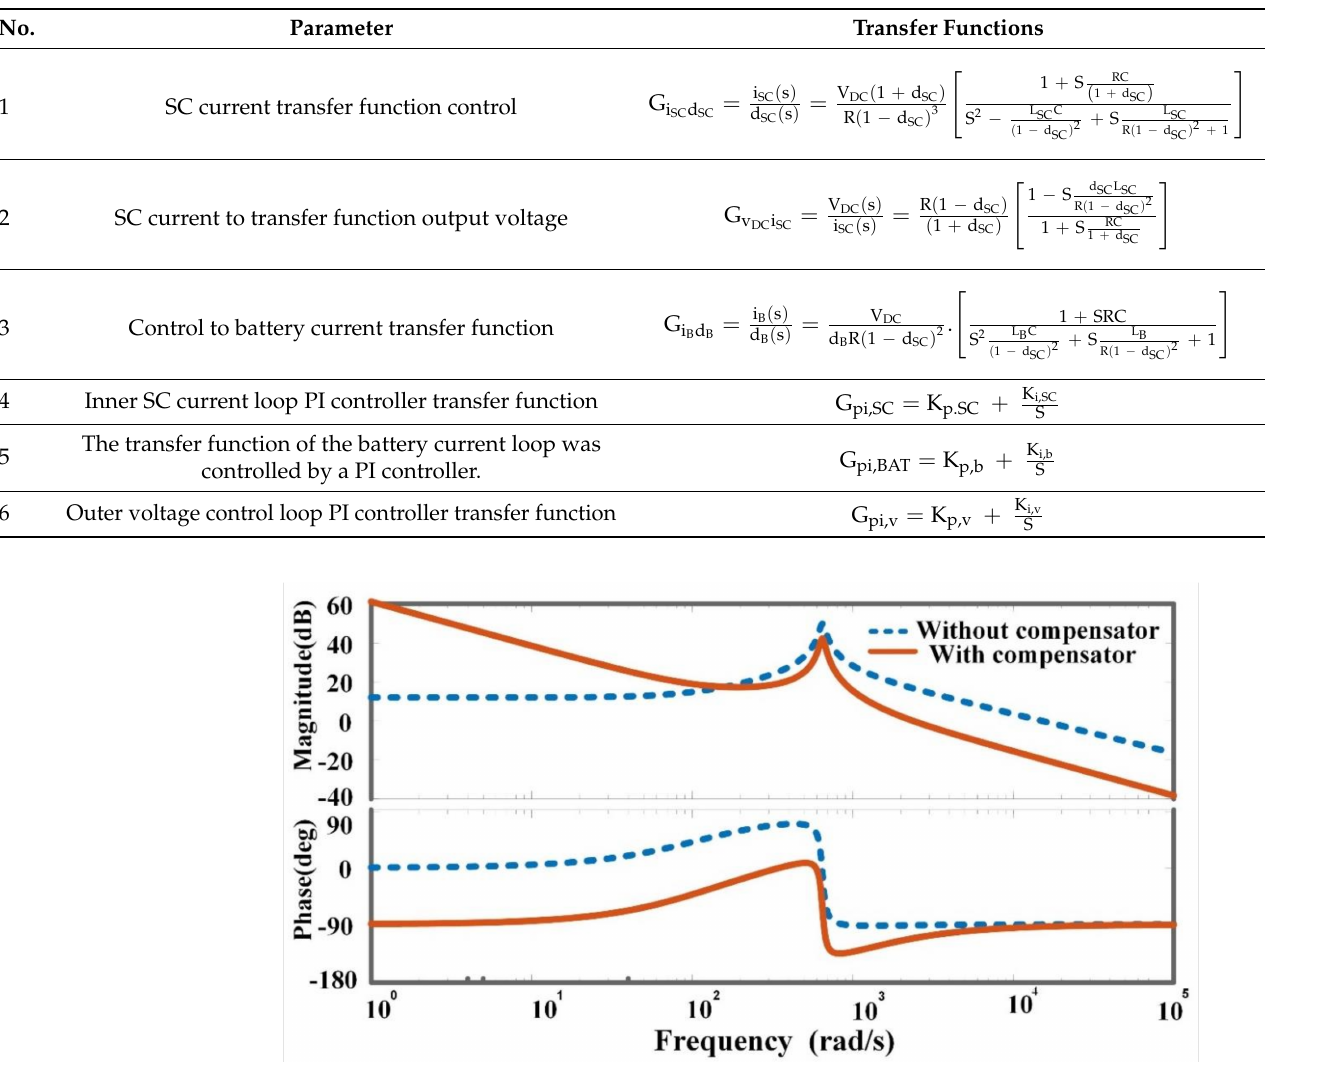
Figure 8. With and without compensation, a Bode plot of the inner SC current